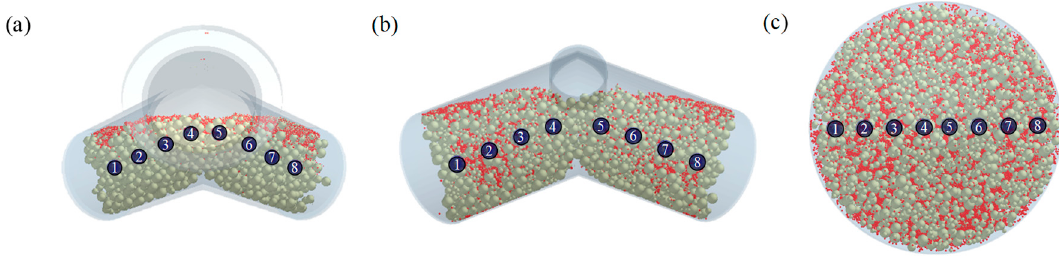
Figure 8. Eight sampling cylinder bins for each blender in the simulation domain: ( a ) V-blender at laboratory-scale, ( b ) V-blender at pilot-scale, and ( c ) double-cone blender at pilot-scale. The view from the normal direction of the powder bed surface.